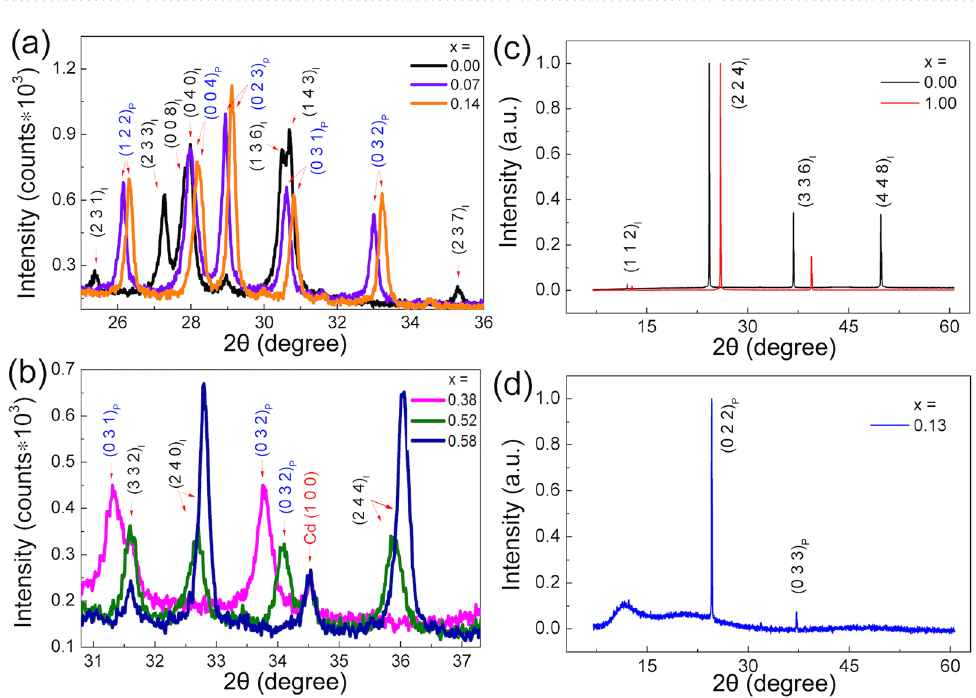
Figure 2. XRD patterns for (Cd 1 − x Zn x ) 3 As 2 . Panel (a): Powder XRD patterns for x = 0, 0.07 and 0.14 for 25° < 2 θ < 36°. The characteristic peaks of (231) I , (233) I and (237) I for a body-center structure and (032) P for a primary structure are labeled. Panel (b): Powder XRD patterns for x = 0.38, 0.52 and 0.58 for 31° < 2 θ < 37°. The peak of (032) P occurs for x = 0.38, while the peaks of (240) I and (244) I occur for x = 0.58. For x = 0.52, we observed two sets of peaks, which indicates the batch has the mixture of two types of crystals. The (100) peak of cadmium at 34.5° occurs in all the XRD patterns with no shift. Panel (c): The diffraction pattern of the (112) I plane for α − Cd 3 As 2 and α − Zn 3 As 2 . Panel (d): The diffraction pattern of the (022) P plane for (Cd 0.87 Zn 0.13 ) 3 As 2